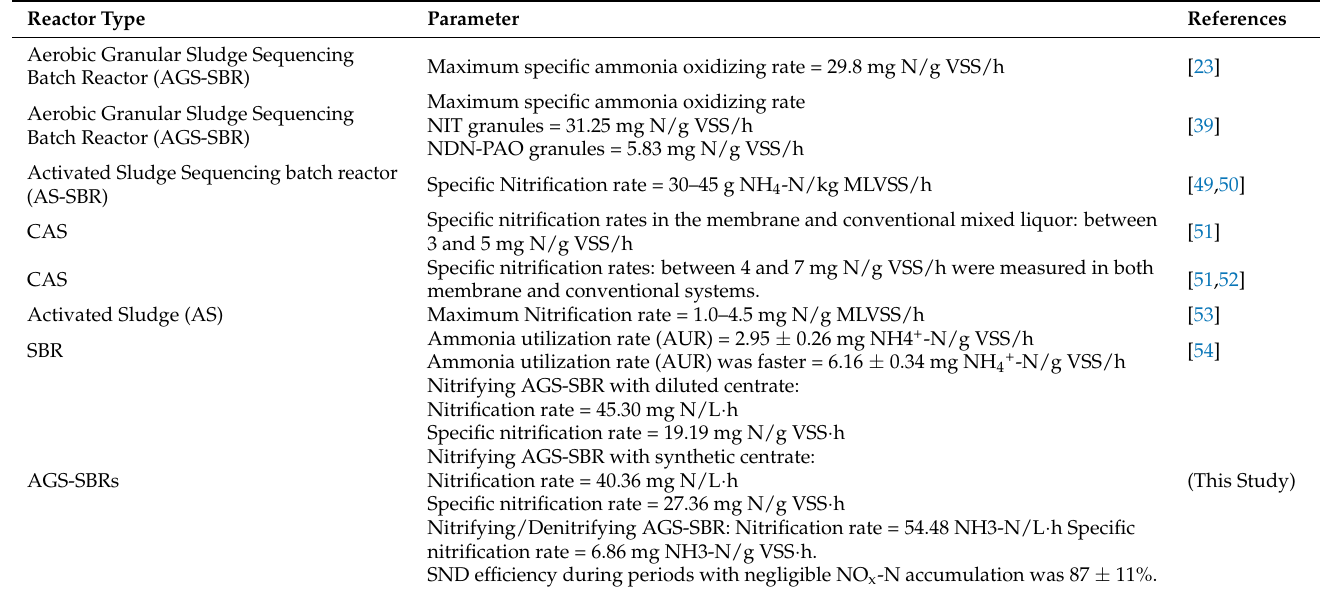
Table 6. Summary of nitrification and specific nitrification rates reported in the literature.